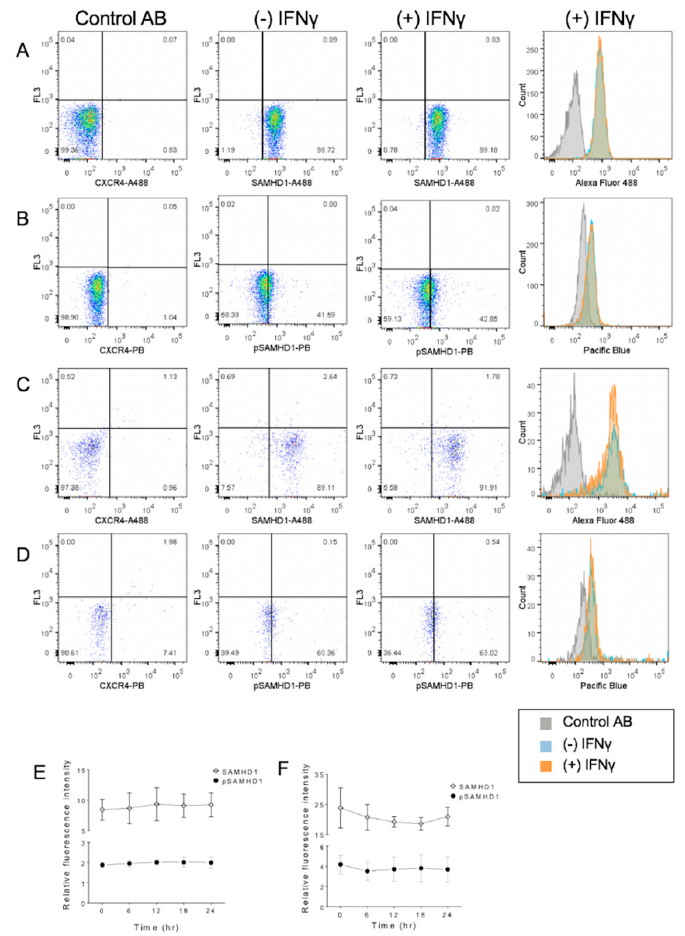
Figure 6. Flow cytometric detection of cellular localization of total and phosphorylated SAMHD1 in purified primary feline CD4 + lymphocytes maintained in IL-2. Samples consisted of lymphocytes stained with a fluorochrome-labeled non-binding CXCR4 antibody as the negative control, and whole cells ( A , B ) or nuclei ( C , D ) were stained with anti-SAMHD1 or anti-pSAMHD 6 h after treatment with IFN γ . No significant differences in relative fluorescence attributable to IFN γ treatment were observed. Summary of results over time in whole cells ( E ) and nuclei ( F ).